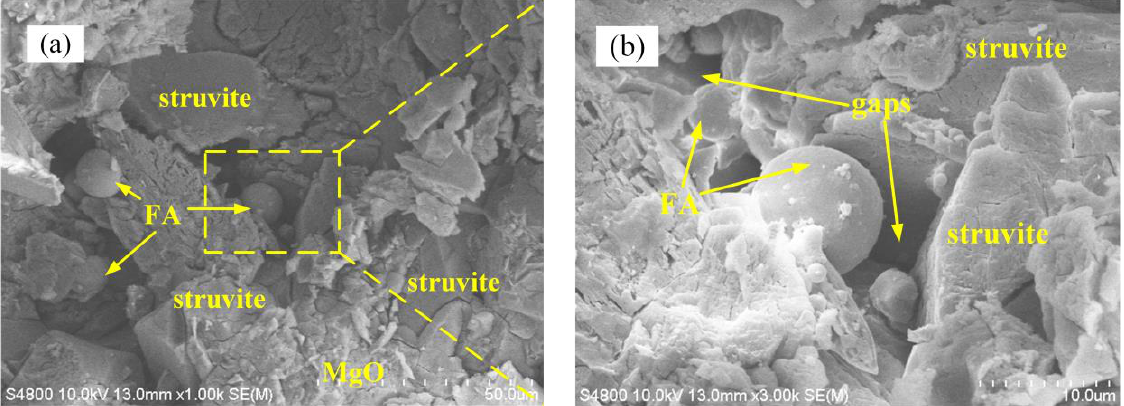
Figure 22. SEM microstructure of the MPC with the addition of FA at 28 d: ( a ) 1000 magnification, ( b ) 3000 magnification.